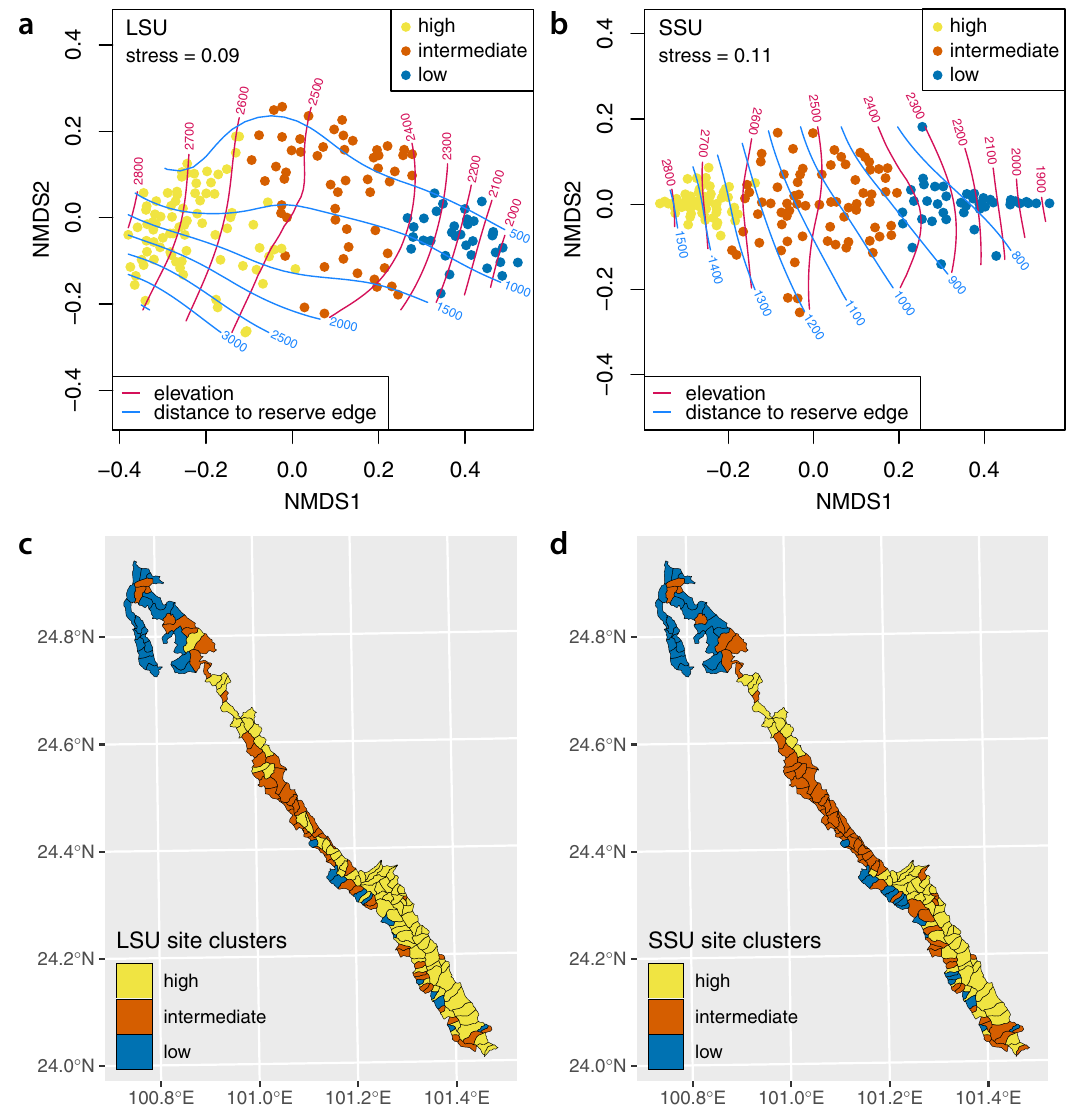
Fig. 5 Vertebrate community composition by patrol area. a , b Non-metric multidimensional scaling plots representing mean pairwise Jaccard distances among patrol areas. Each point represents a single patrol area, coloured according to the cluster that it falls into (see Supplementary Fig. 8). Red and blue contours show elevation and distance to the reserve edge respectively (both in metres). Clusters correspond broadly to high-, intermediate- and low- elevation sites. c , d Maps showing distribution of clusters across the Ailaoshan